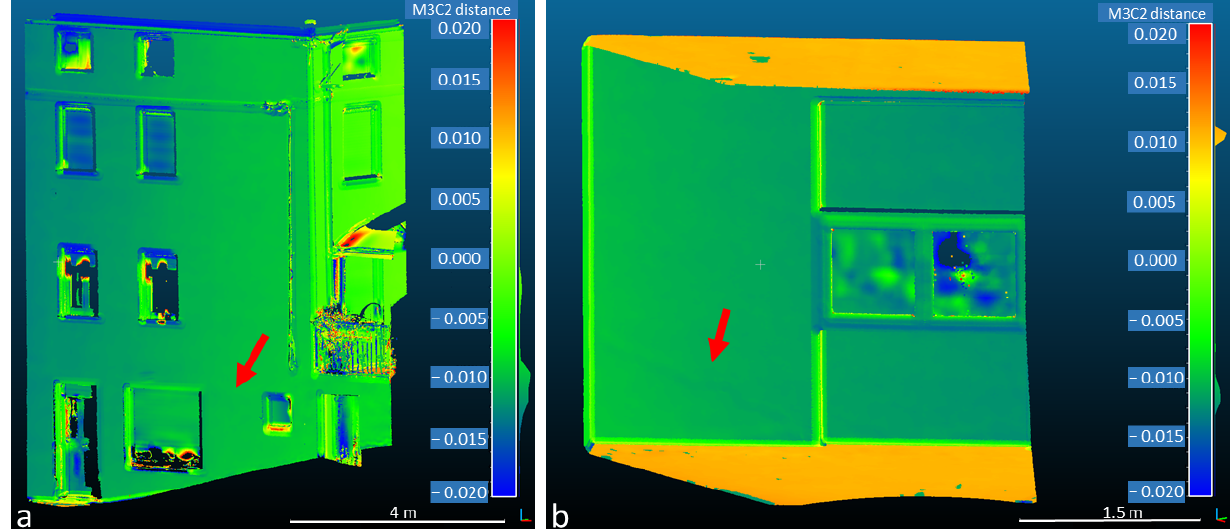
Figure 11. Comparisons between the first and the last scans performed with TLS in Cappellazi ( a ) and in the portico of Rovegliana Church ( b ). The red arrows indicate the main cracks which are not clearly visible.